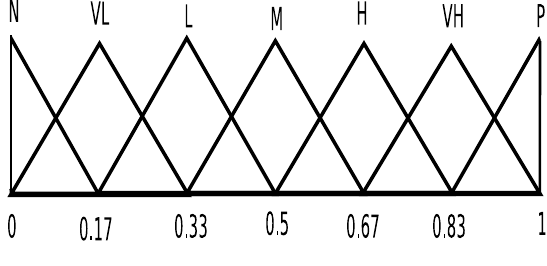
Fig. 1. A linguistic term set and its semantic Other authors use a non-trapezoidal representa- tion, e.g., Gaussian functions 3